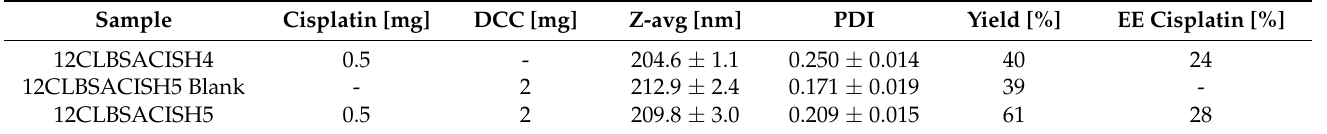
Table 4. Simultaneous encapsulation of the active agents sorafenib and cisplatin with BSA additive and DCC as cross-linker, using 1:5 oil-in-water ratio, 1% ( w/v ) 12CL encapsulating polymer concentration, and 1% ( w/v ) PVA emulsifier.